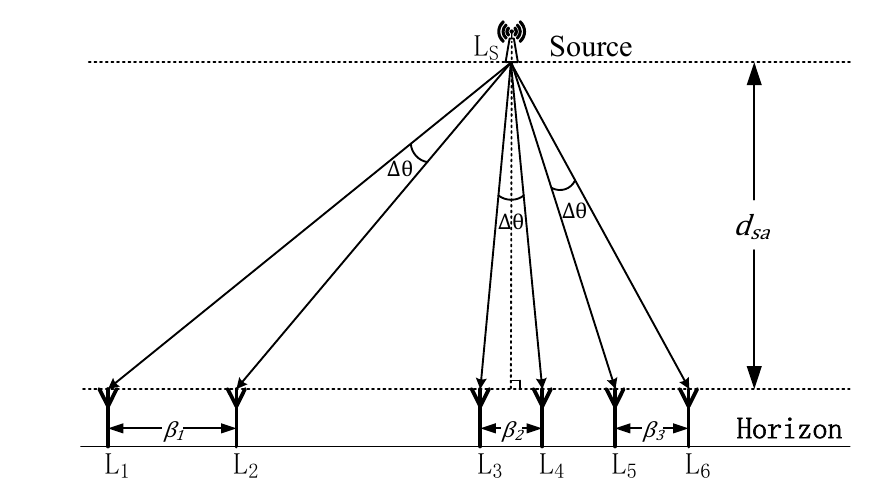
Figure 2. Diagram of the dynamic auxiliary decision mode.